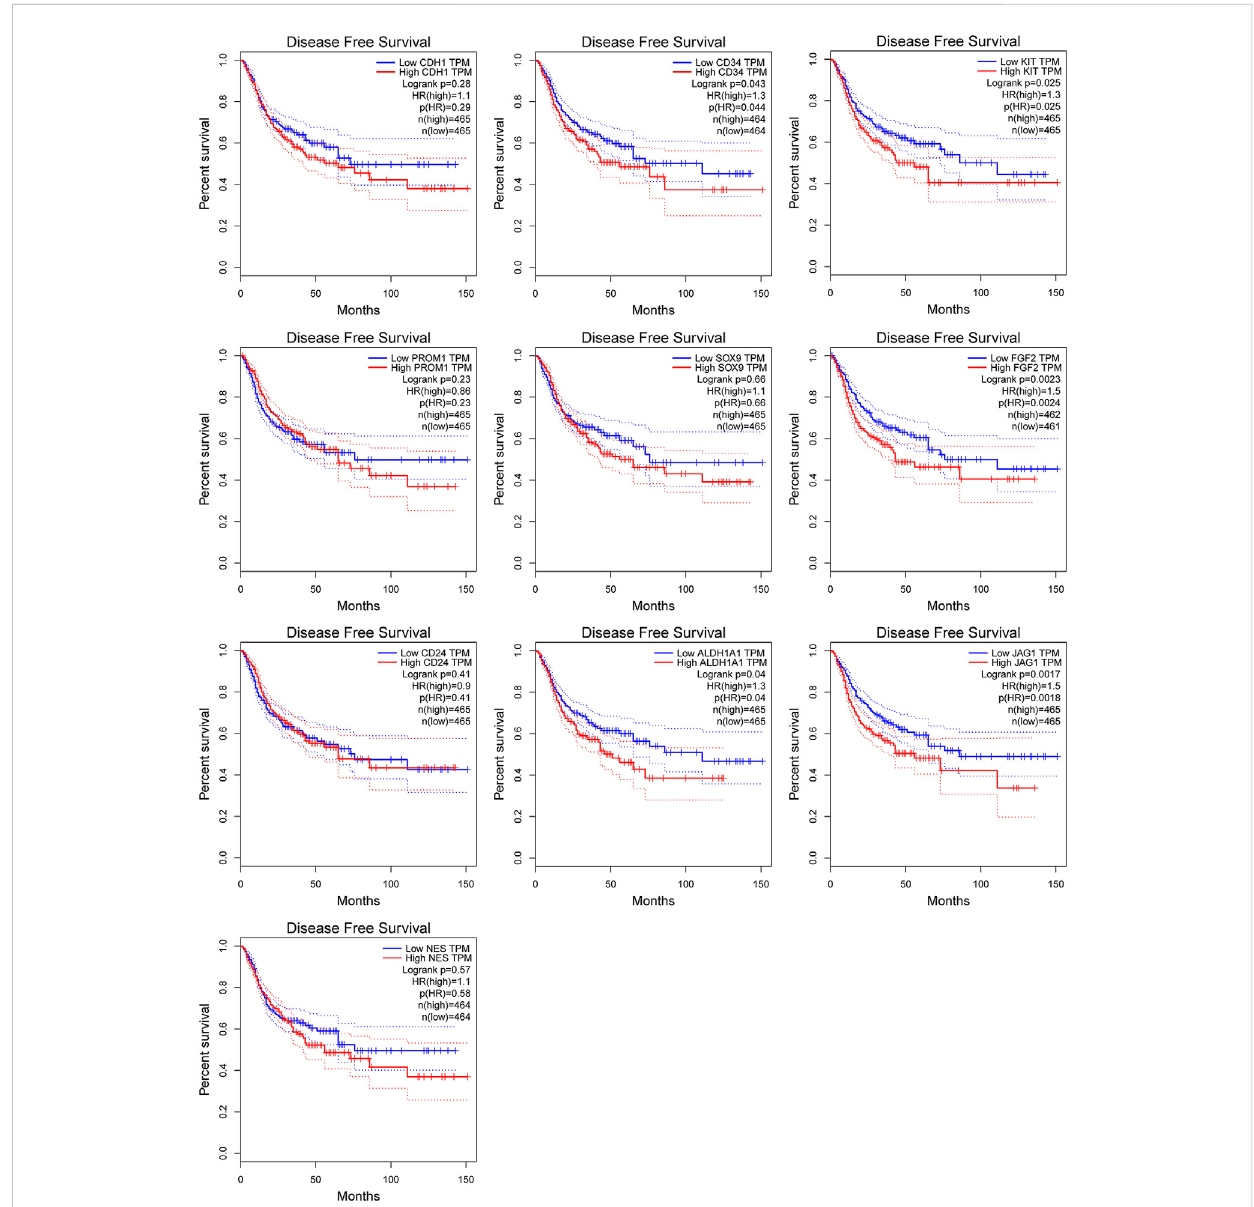
FIGURE 10 Kaplan-Meier curves of hub genes expression and disease-free survival in gastrointestinal tumors. Data are presented as the hazard ratio with a 95% con fi dence interval. Log-rank p < 0.05 was regarded as statistically signi fi